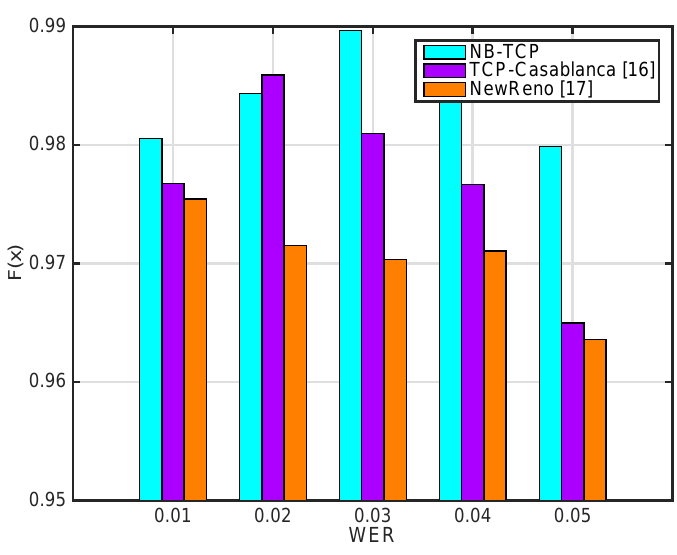
Figure 5. Fairness Index versus WER.